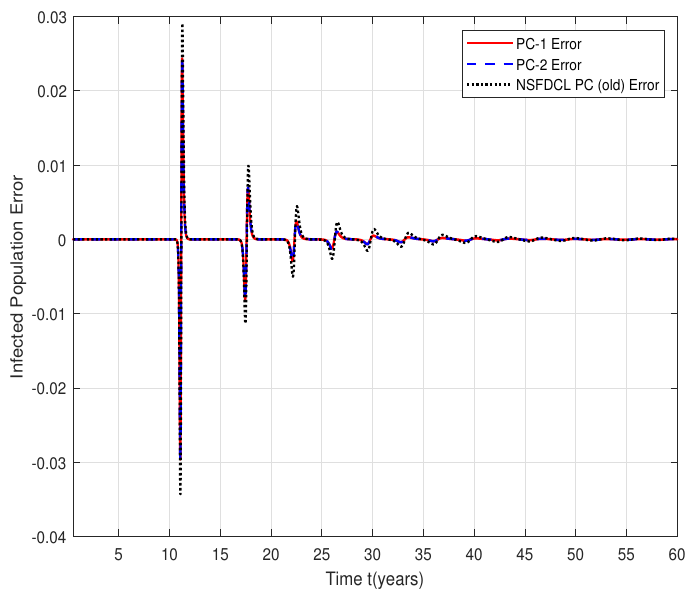
Figure 2. Absolute errors for the system (2) with h= 0.01 by the new schemes, the proposed method in [28] and I.C. ( S 0 , I 0 , R 0 ) = ( 0.9,0.05,0.05 ) with β = 123, µ = 0.04, ν = 24, ( R 0 > 1 ) using Runge–Kutta as a reference solution.